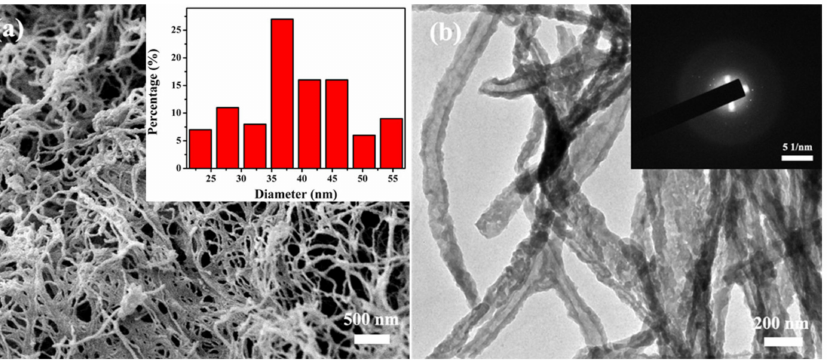
Figure 2. ( a ) SEM image and TEM image of MBG nanofiber scaffold (Inset shows the diameter distribution ( a ) and SAED pattern ( b ) of MBG nanofiber scaffold).